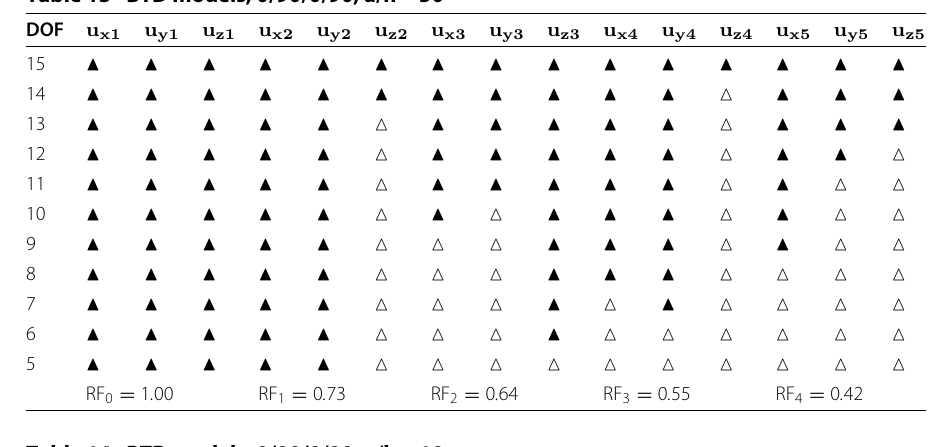
Table 14 BTD models, 0/90/0/90, a/h =